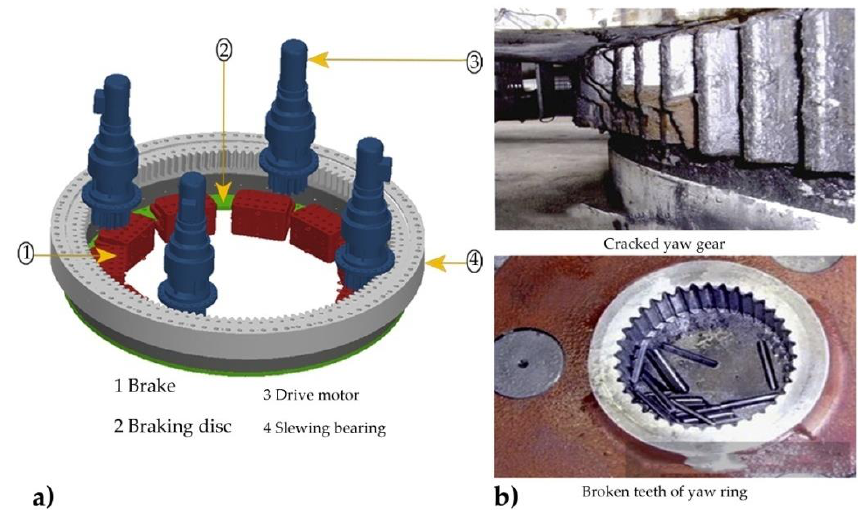
Figure 6. Yaw system structure and failure illustration. ( a ) Graphical illustration of yaw system components. ( b ) Some failure mode types of the yaw system. Reproduced from [87], Elsevier and from [111], Elsevier.